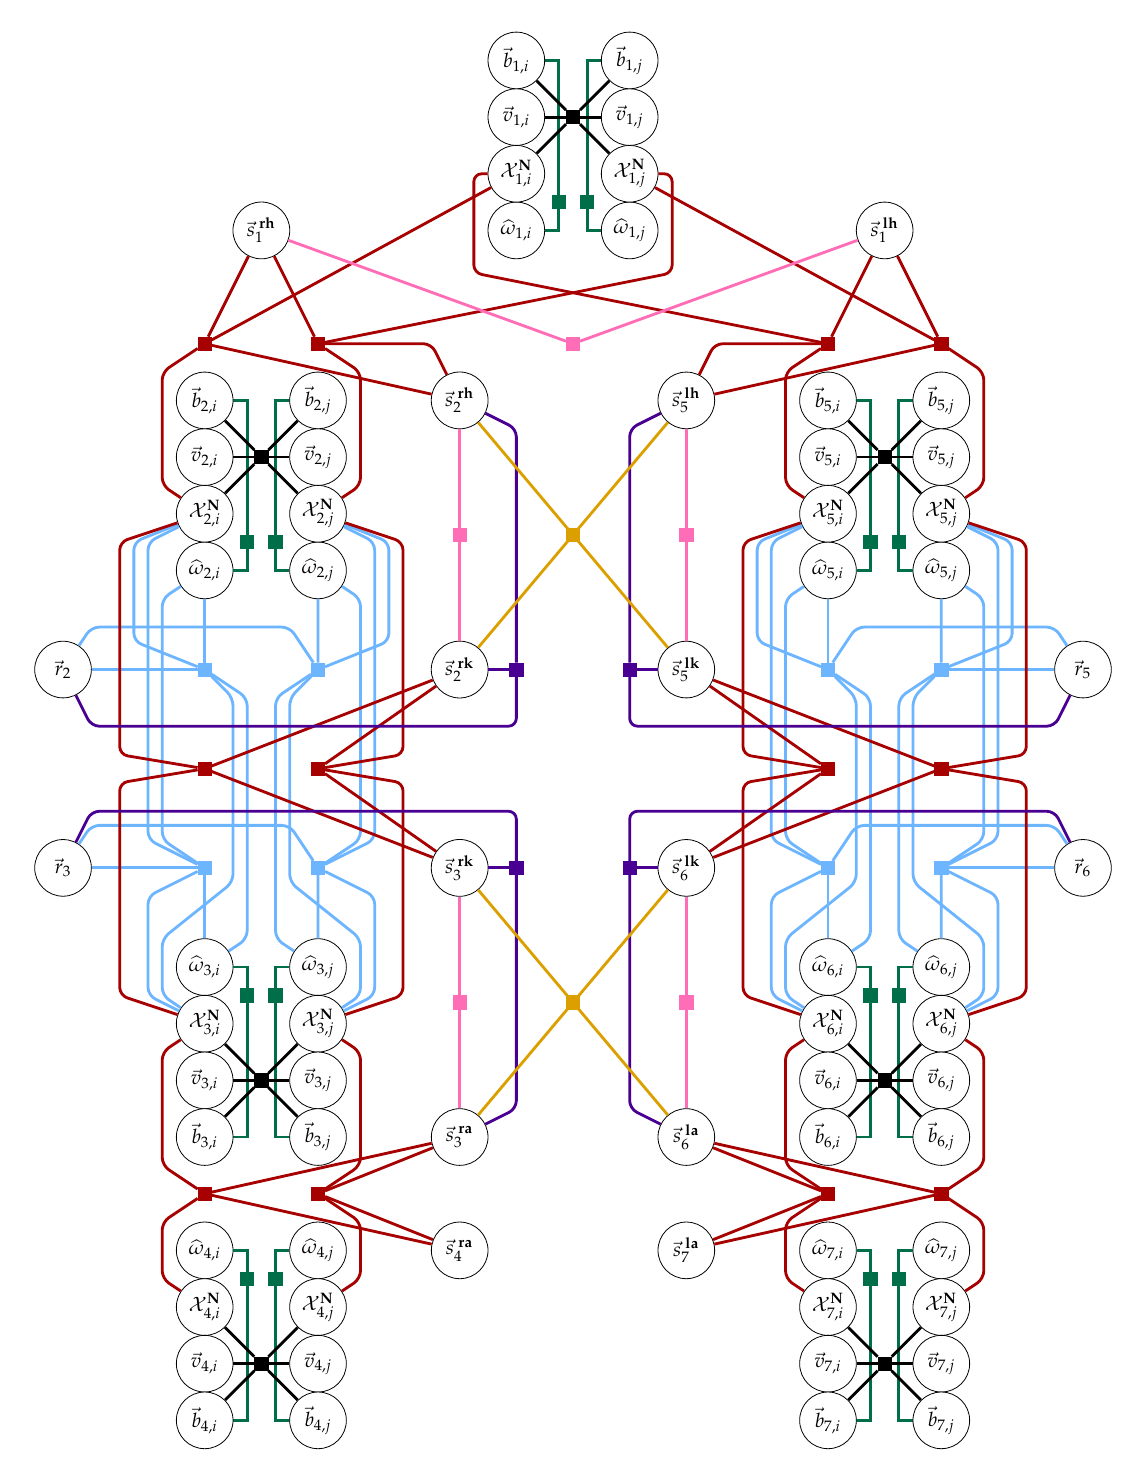
Figure 3. Factor graph representation of the problem for consecutive keyframes i and j . Variables are represented as circles, whereas the connecting factors are represented as solid squares. For readability, factors and their connecting lines to variables are colored according to factor type: black is the IMU dynamics factor, teal is the angular velocity model, pink is anthropometry, blue is knee hinge kinematics, red is the constrained joint center between IMUs model, violet is the knee axis to segment length quasi-orthogonality factor, and orange is the segment length discrepancy factor. All variable notation is defined in Section